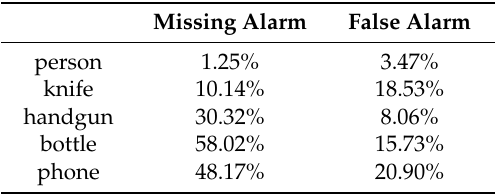
Table 5. Missing alarm and false alarm of IFRCNN.